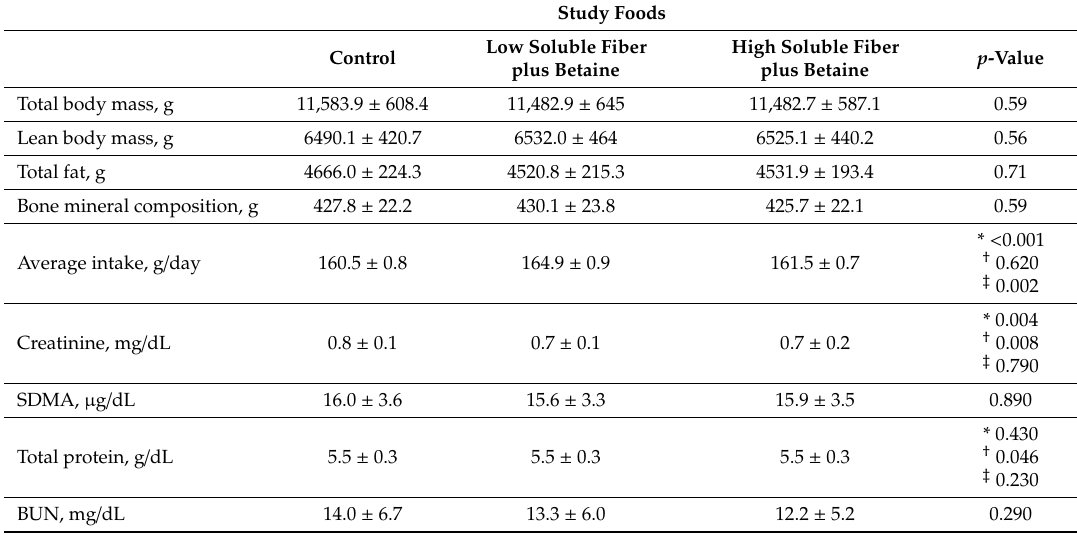
Table 2. Body composition parameters and average food intake in dogs with chronic kidney disease